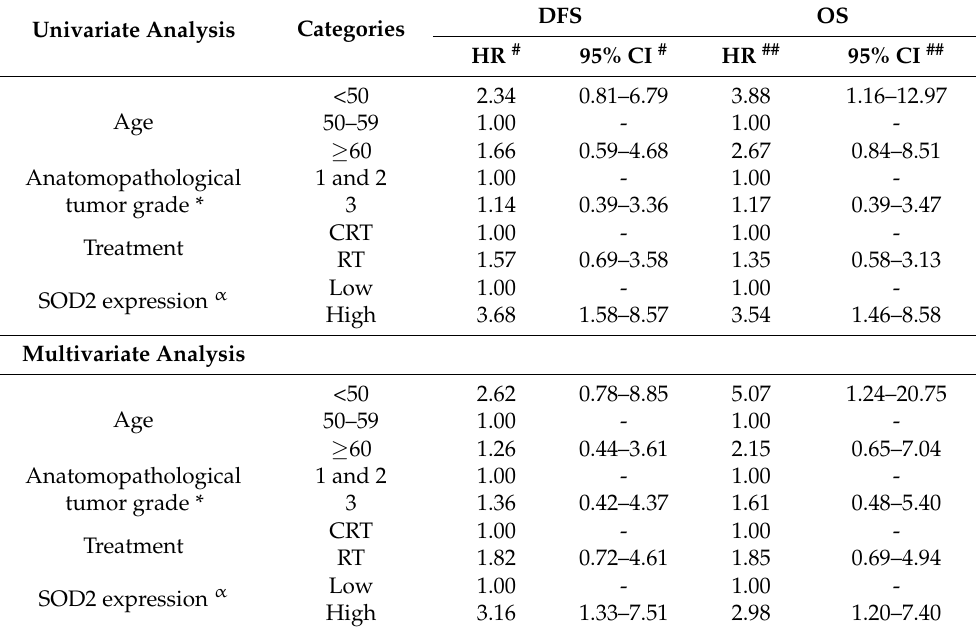
Table 3. Univariate and multivariate Cox regression analyses for disease-free survival and overall survival according to patient’s age, tumor grade, treatment, and SOD2 expression ( n = 55). Univariate Analysis